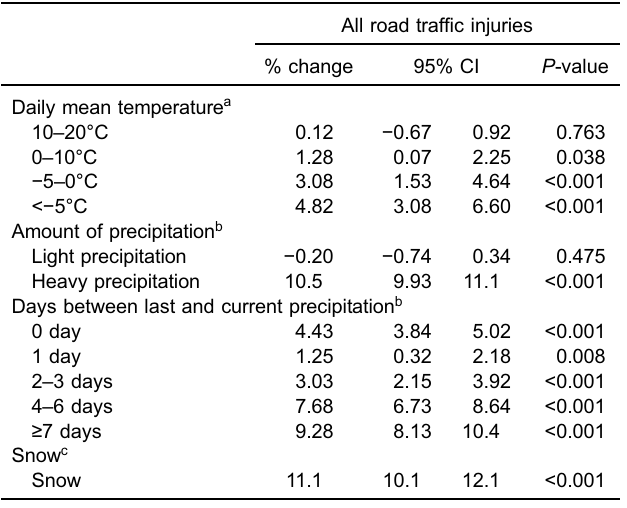
Table 3. Interactive effect of temperature and snow on road traf fi c injuries, 2007 to